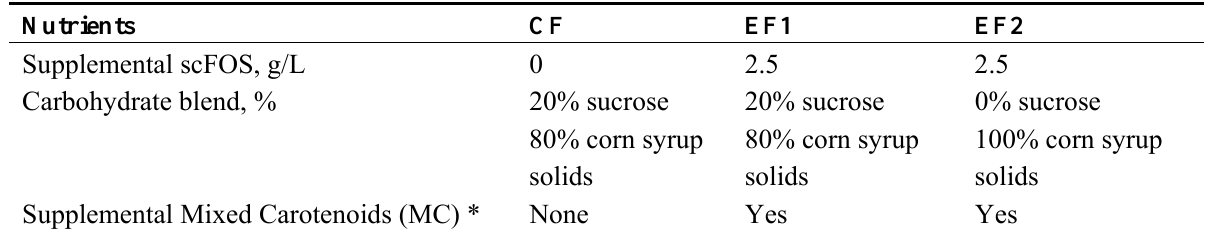
Table 1. Ingredient Compositional Differences between Study